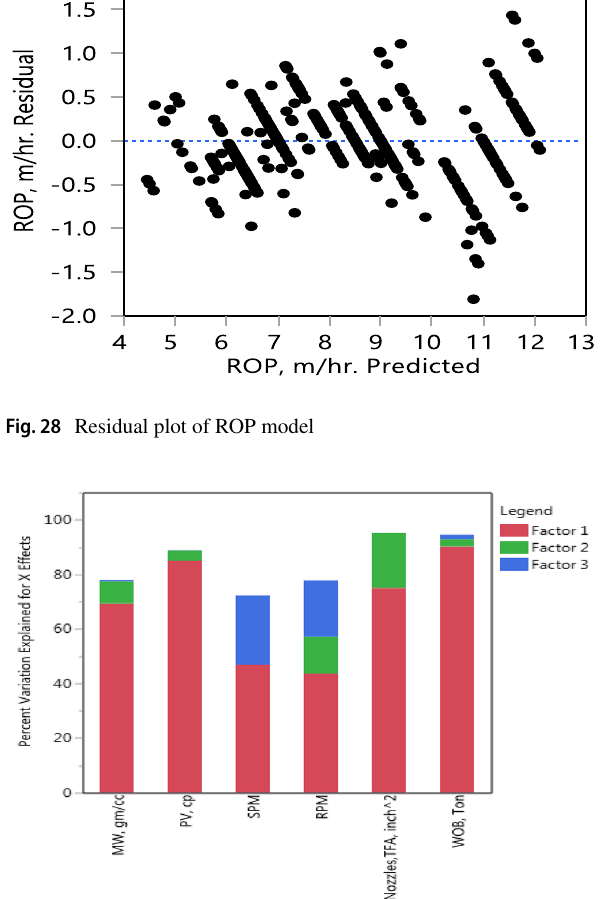
Fig. 29 Percent of variation explained by each factor for X -variables (ROP model)